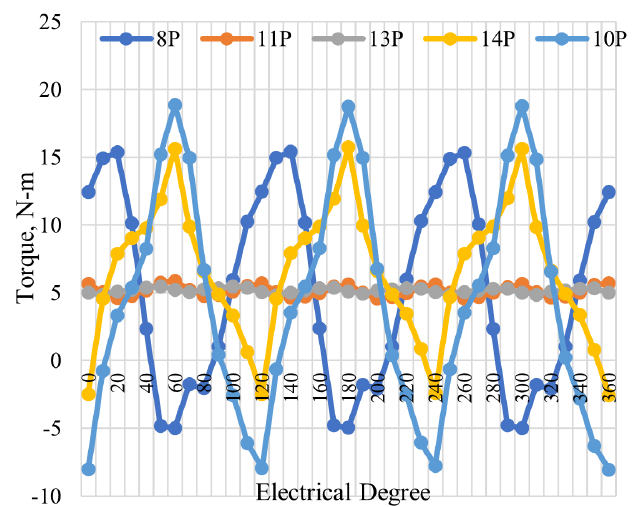
Figure 10. Instantaneous torques of different rotors.